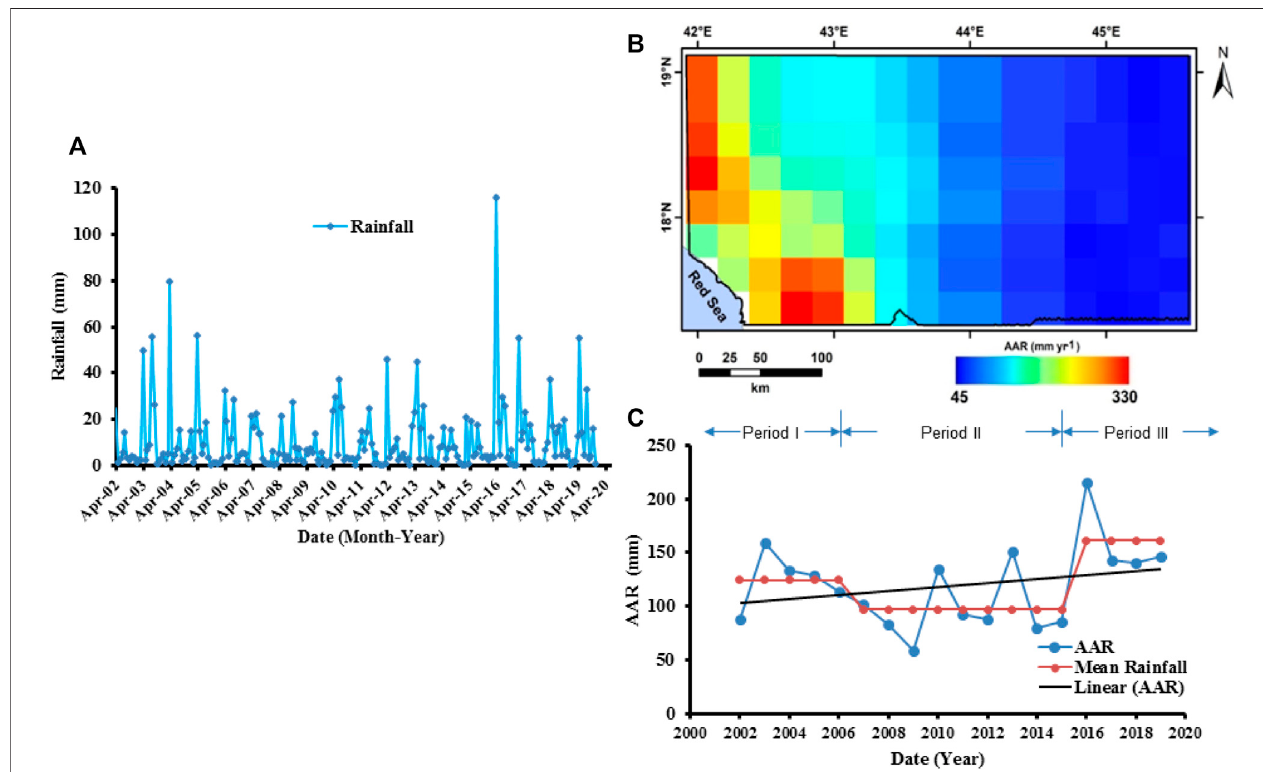
FIGURE 4 | (A) Monthly rainfall rate (mm/month) derived from TRMM data over the area. (B) the average annual rainfall (AAR) was taken from TRMM data. (C) Annual rainfall rate (mm) for the research area.